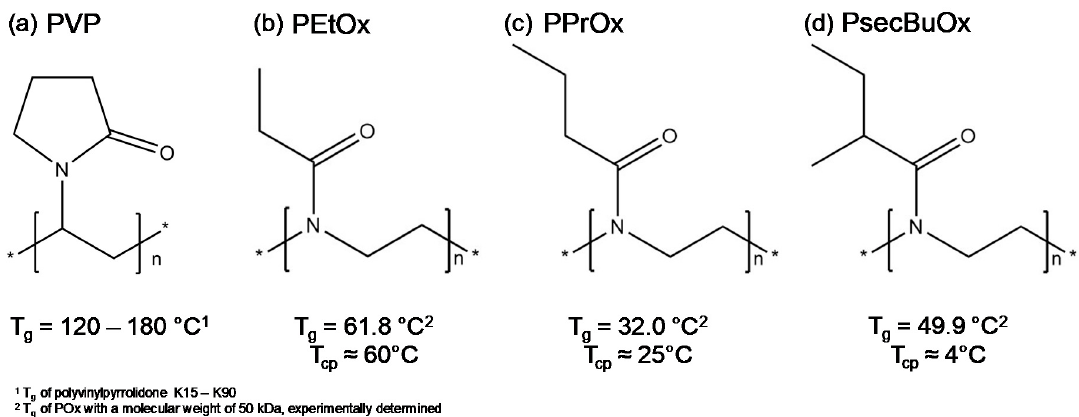
Figure 2. Chemical structure and corresponding glass transition temperature (T g ) of polyvinylpyrrolidone ( a ) [22], poly(2-ethyl-2-oxazoline) ( b ), poly(2- n -propyl-2-oxazoline) ( c ) and poly(2- sec -butyl-2-oxazoline) ( d ). Created with ChemDraw Professional software (PerkinElmer). For poly(2-alkyl-2-oxazolines), cloud point temperatures (T cp ) are also given [18].